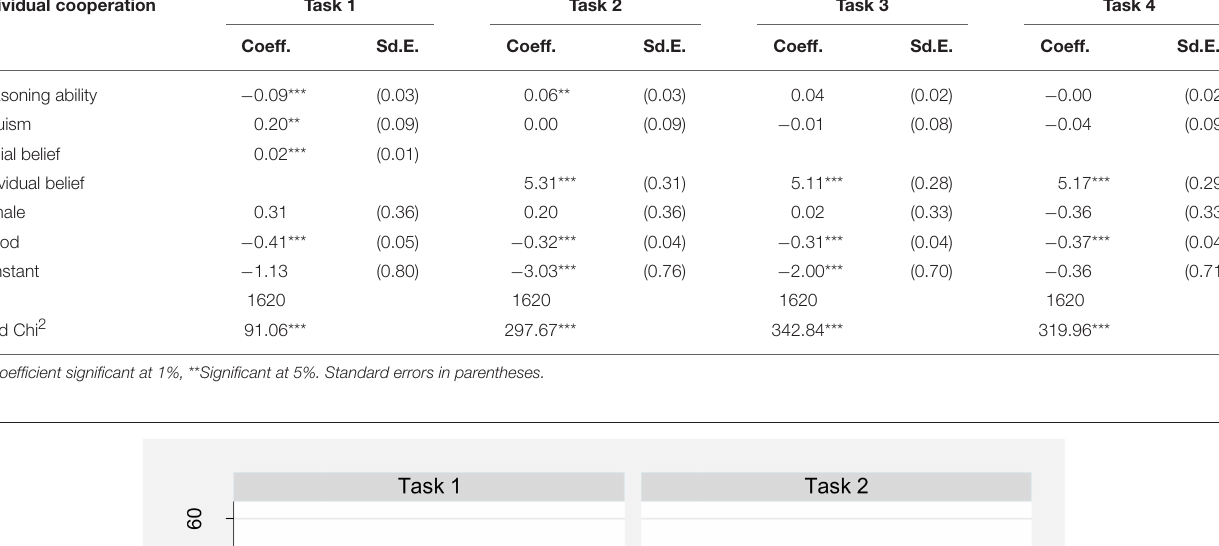
TABLE 6 | Random-effects panel logit regressions of individual cooperation on individual characteristics, period and beliefs. Individual cooperation Task 1